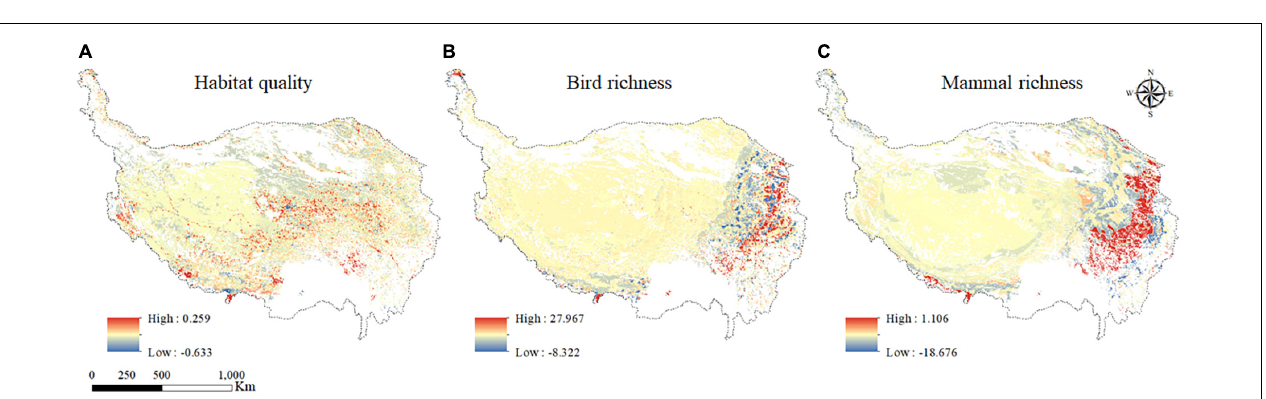
FIGURE 6 | The spatial distribution of maximum interaction effects between grazing activities and the factor on habitat quality (A) ; bird species richness (B) ; and mammal richness (C) in the grazing regions on the QTP.